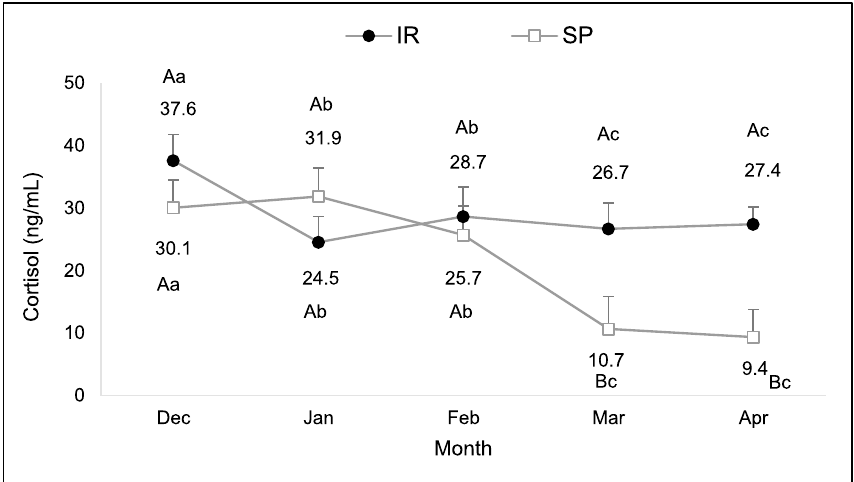
Figure 4. Serum cortisol concentration of heifers raised on silvopastoral (SP) or intensive rotational (IR) systems from December to April. There was an interaction between system and month. A,B Different capital letters indicate a significant difference between systems. a,b,c Different lowercase letters indicate a significant difference between